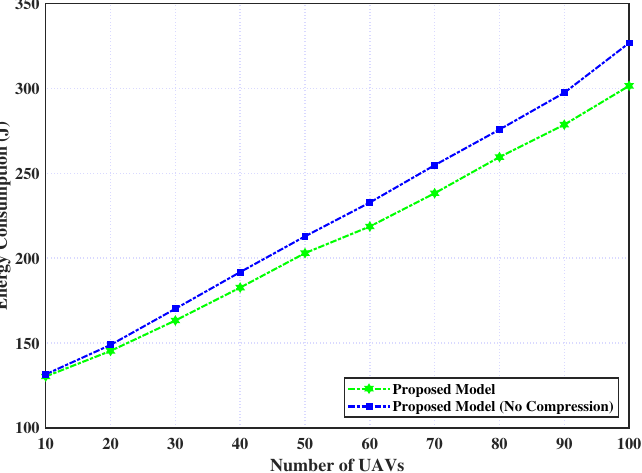
Figure 3. Proposed model with and without compression layer over number of